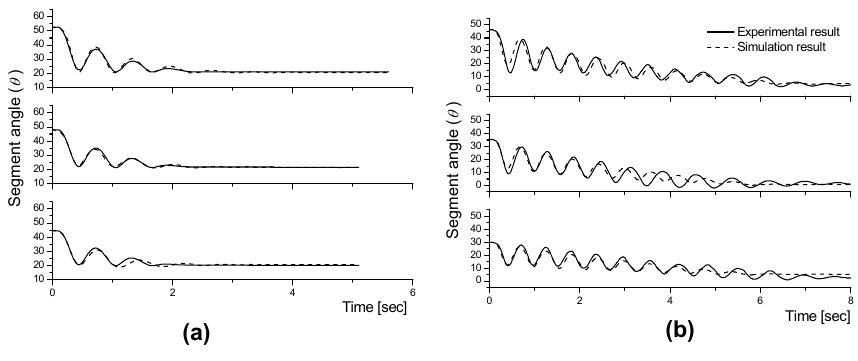
Fig.5. Simulated and experimental pendulum trajectories of two participants with the smallest NRMSE (a) and the greatest NRMSE (b).